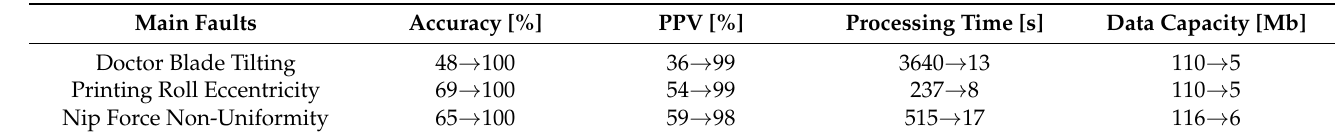
Table 22. Smart data diagnosis improvement with window size adjustment.